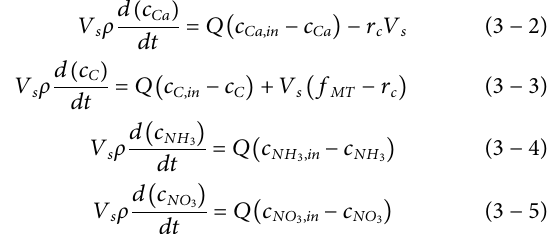
Frontiers in Chemical Engineering |